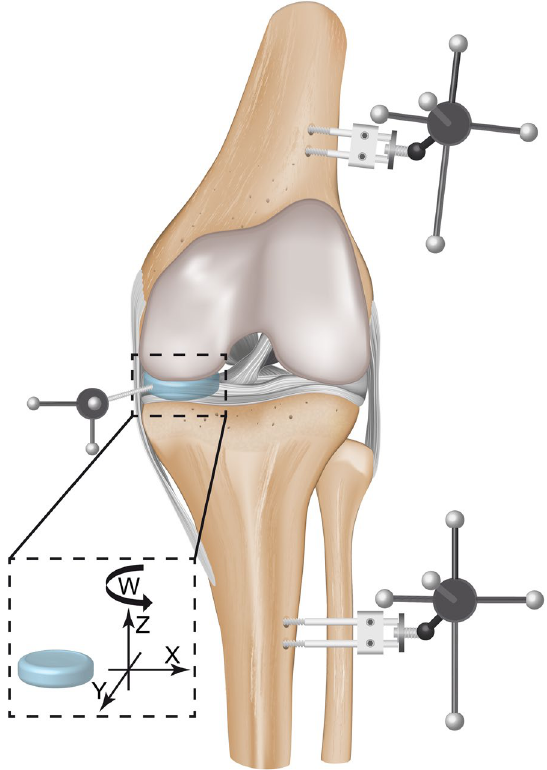
Fig. 4 Illustrated frontal view on the knee joint: Coordinate system and the respective three translational axes as well as the rotation W around the corresponding Z